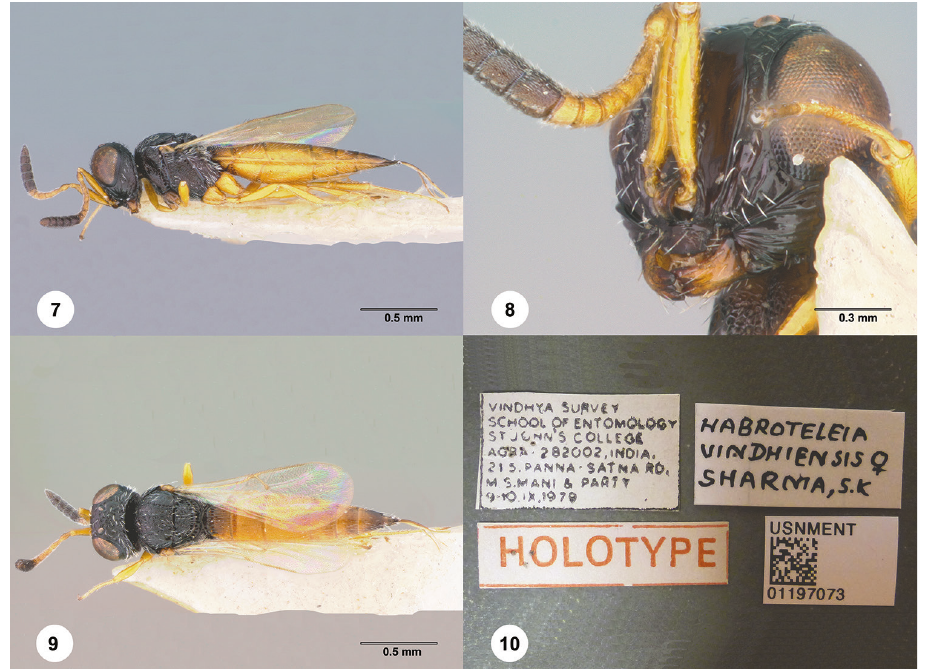
Figures 7–10. Baryconus vindhiensis , female, holotype (USNMENT01197073). 7 Lateral habitus 8 Head, lateral view 9 Dorsal habitus 10 Labels. gose. Setation of ventral metapleural area: dense. Color of legs: orange-yellow to dark brown; dark brown to black. Sculpture of hind coxa: densely punctate. Color of metasoma: black; black with T3–T4 and S2–S5 partly brown to yellow. T1 horn in female: present. Sculpture of posterior margin of T1 in female: densely lon- gitudinally striate, punctate rugulose in interstices. Transverse sulcus on T2: present. Sculpture of T2–T5: densely longitudinally striate, with fine punctures in interstices. Sculpture of T6 in female: densely longitudinally striate, with fine punctures in in- terstices. Length of T6 in female: distinctly longer than wide. Apex of T6 in female: round. Sculpture of S2: longitudinally striate rugose. Sculpture of T1 in male: densely longitudinally striate, punctate rugulose in interstices. Male T8 apical spine: present. Diagnosis. This species is most similar to H. persimilis but can be distinguished by its short median propodeal projection and longitudinally striate T6 in female. Link to distribution map. [http://hol.osu.edu/map-large.html?id=4535] Material examined. Holotype of Habroteleia flavipes Kieffer, female: INDONE- SIA : Sumatera Utara Prov., Sumatra Isl., Pangherang Pisang, X.1890 – III.1891, E. Modigliani, MCSN 0001 (deposited in MCSN). Holotype of Habroteleia bharatensis Saraswat, female: INDIA : West Bengal St., 16.4, Poro North, 6.IV–24.IV.1976, M. S. Mani, USNMENT01197132 (deposited in USNM). Syntype of Chrestoteleia bak- eri Kieffer, female: PHILIPPINES : Laguna Prov., Los Baños, no date, Baker,